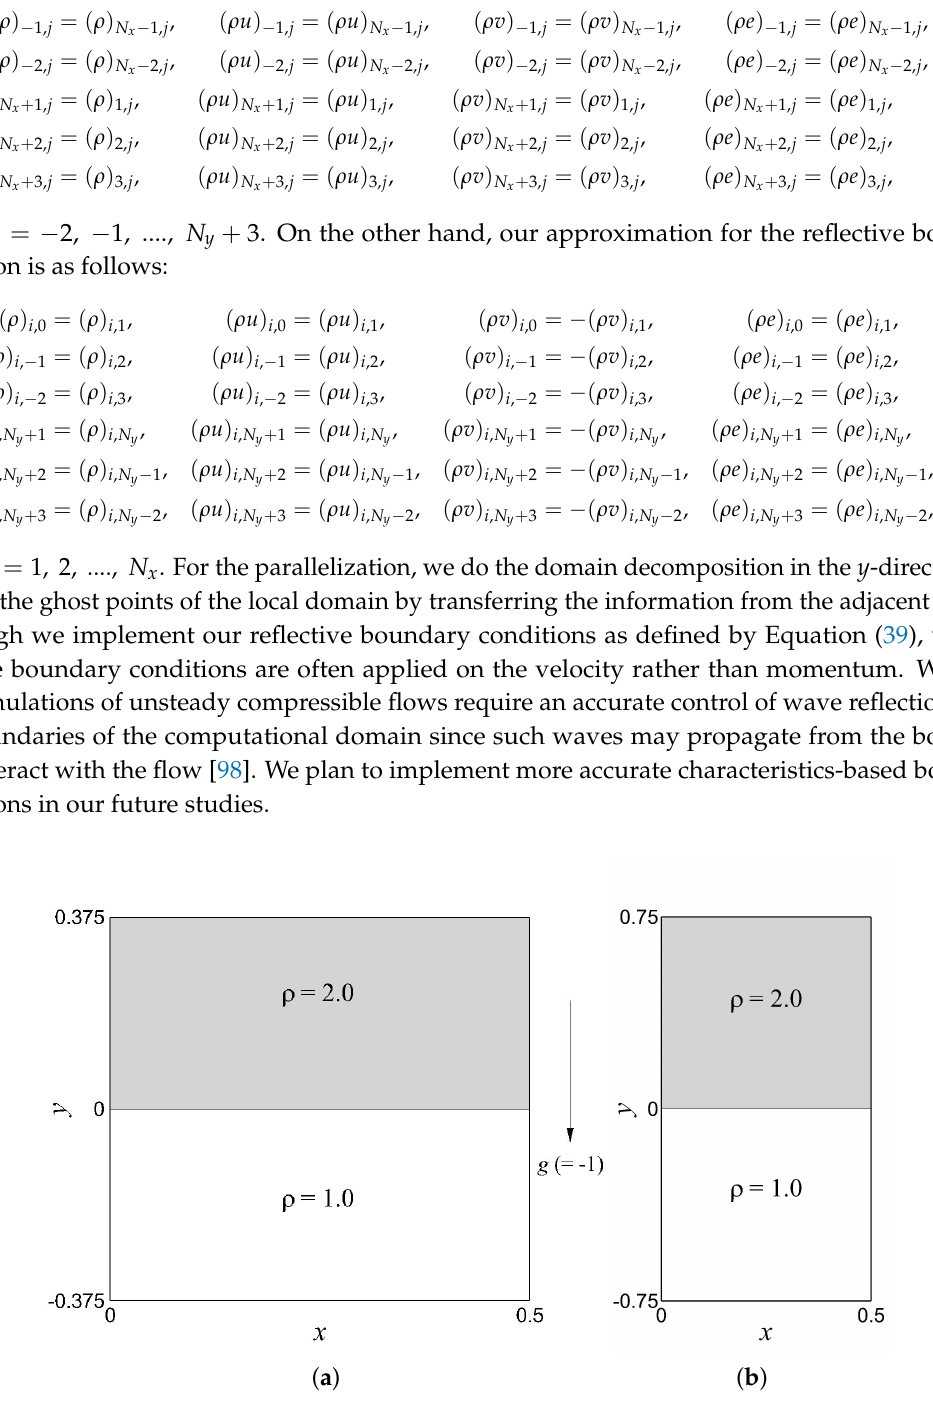
Figure 1. Computational domain and initial conditions for the ( a ) multi-mode and ( b ) single-mode Rayleigh–Taylor instability (RTI) test case. Please note that we apply periodic boundary condition on left and right boundaries, and reflective boundary condition on top and bottom